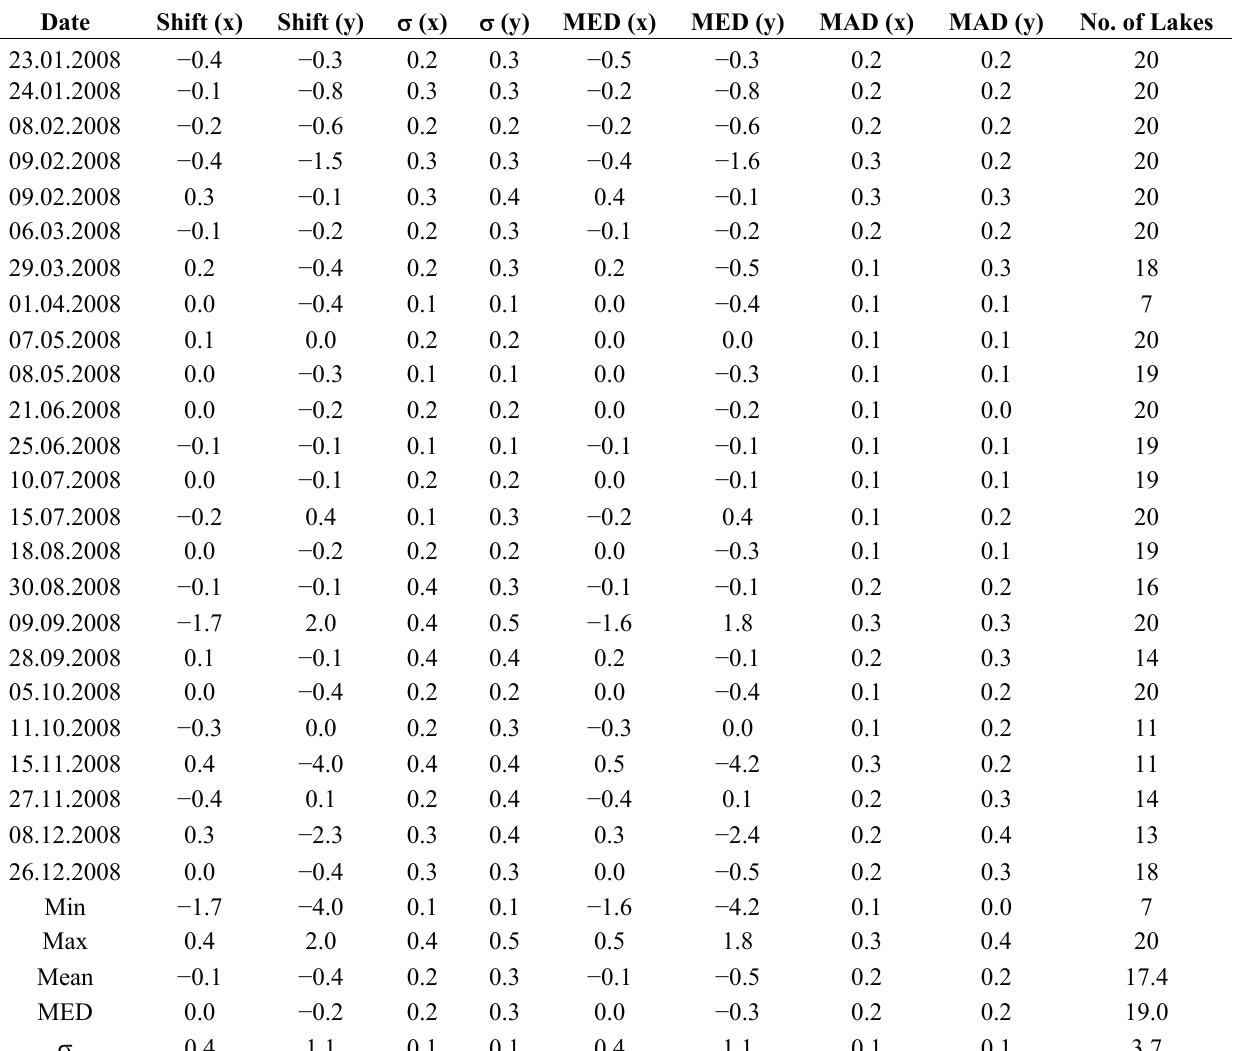
Table 3. Absolute accuracy evaluation; statistical summary from the lake shifts (equally weighted) in AVHRR images acquired from Metop-A. All values are in pixels except the number of lakes and are derived from signed values.